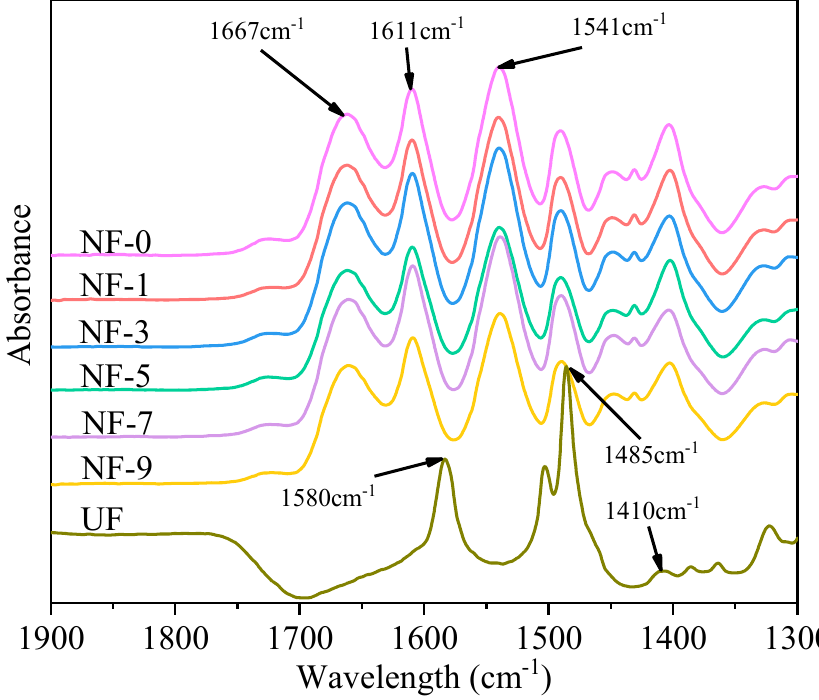
to the reaction zone, leading to the hydrolysis reaction of TMC and formation of more carboxyl groups, and the crosslinking degree of NF membranes decreased. The XPS can also test the ratio of oxygen in different functional groups. The O1s has two peaks at binding energies of 531.5 eV and 533 eV, representing carbonyl oxygen bond- ing (O=C-O/N-C=O) and carboxyl oxygen bonding (O=C-O) [64], respectively. As seen in Figure 4, the ratio of carboxyl oxygen (At%) rose with the DWCNT dosage increase, which indicated that the crosslinking degree decreased and that the number of carboxyl groups Figure 2. Infrared spectrum of membrane with different DWCNT dosages. Figure 2. Infrared spectrum of membrane with different DWCNT dosages. on the NF membrane surface increased.